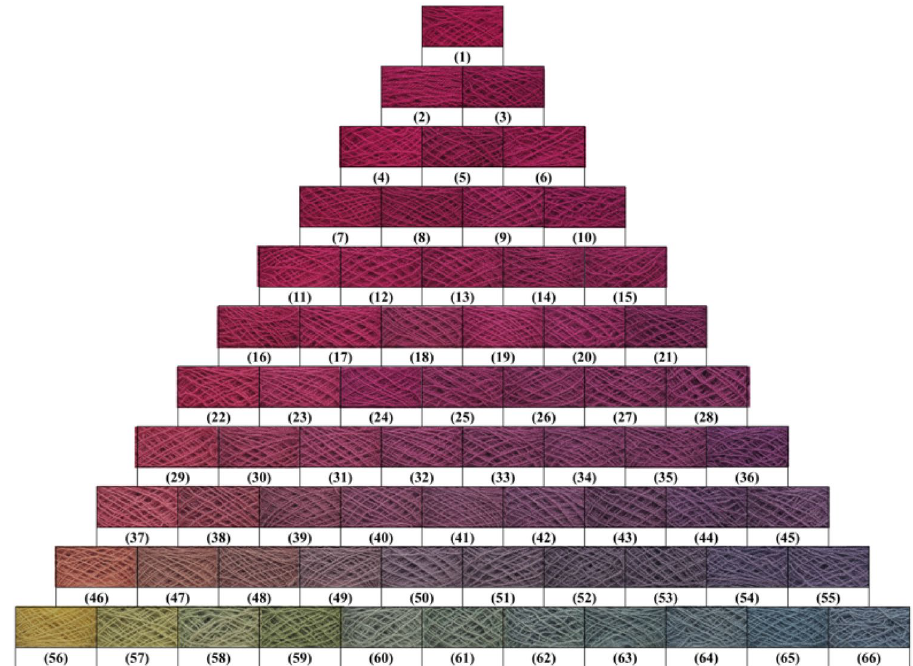
Figure 11. Dyed wool yarn with ternary mixtures of MR, GY, and GB after soaping.